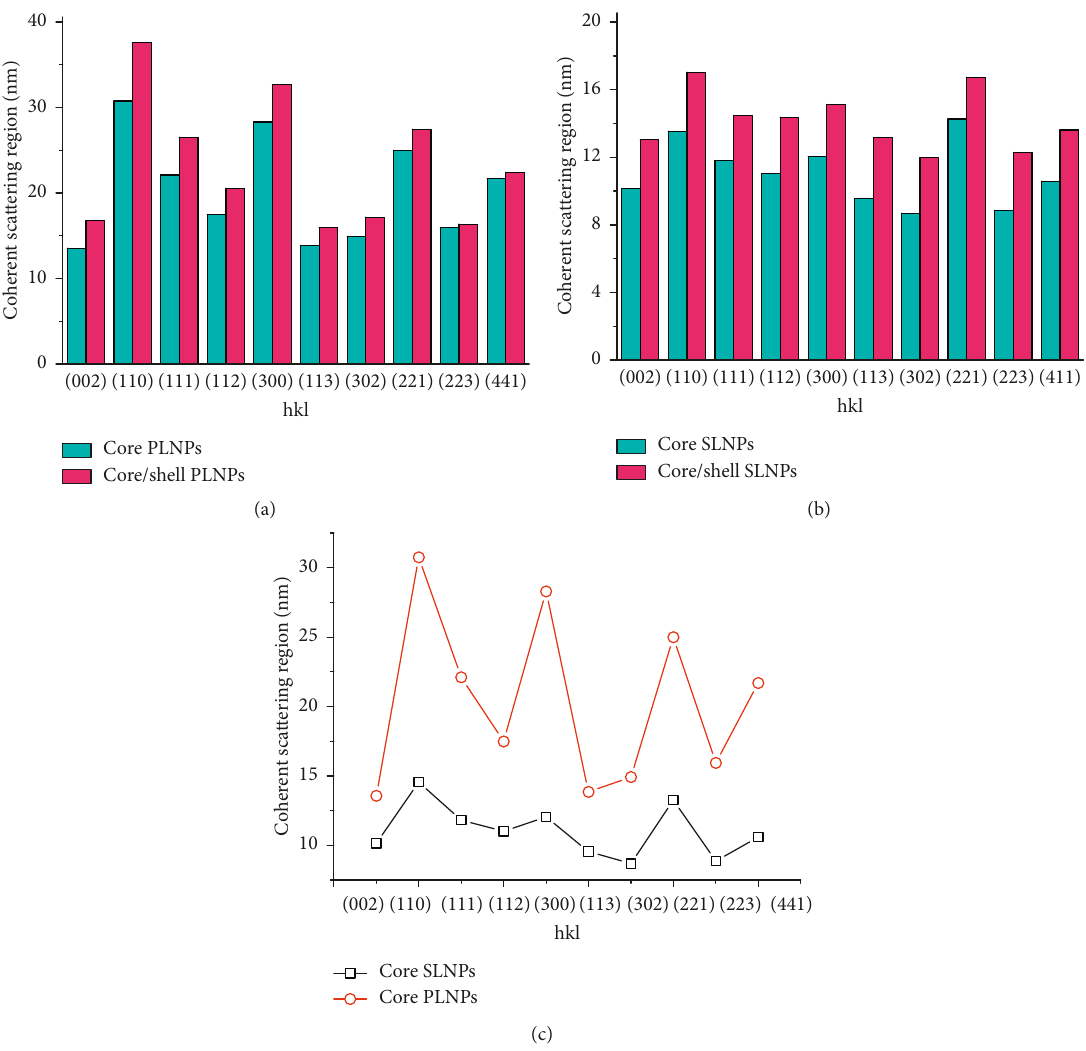
Figure 4: The Debye–Sherrer calculation of the coherent scattering regions of the (a) core nanoplates and core/shell nanoplates and (b) core nanospheres and core/shell nanospheres at different crystallographic orientations. (c) The comparison of the values of the coherent scattering regions of the core nanospheres and core nanoplates at different crystallographic